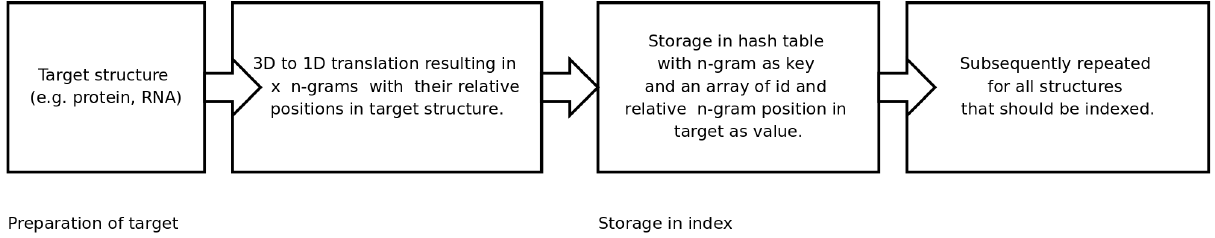
Figure 2. An informal diagram showing the steps issued for the initial generation of the hash table used as index structure for the structural